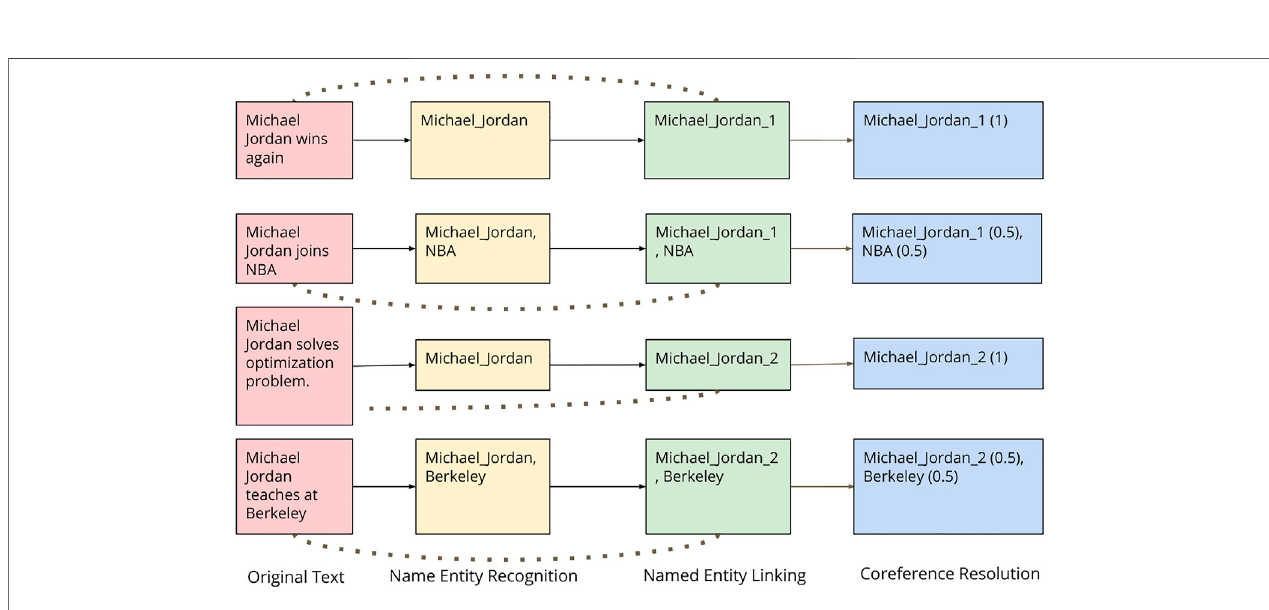
FIGURE 2 | Illustration of different